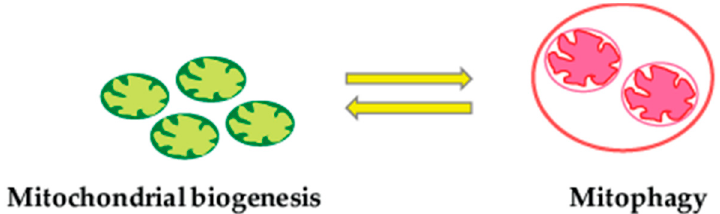
Figure 2. Crosstalk between mitochondrial biogenesis and mitophagy. The crosstalk or coordination between the two opposing processes i.e., selective elimination of damaged or dysfunctional mitochondria by mitophagy and generation of newly synthesized mitochondria by mitochondrial biogenesis is pivotal for the maintenance of mitochondrial energy and cellular homeostasis in response to various physiological and environmental cues.